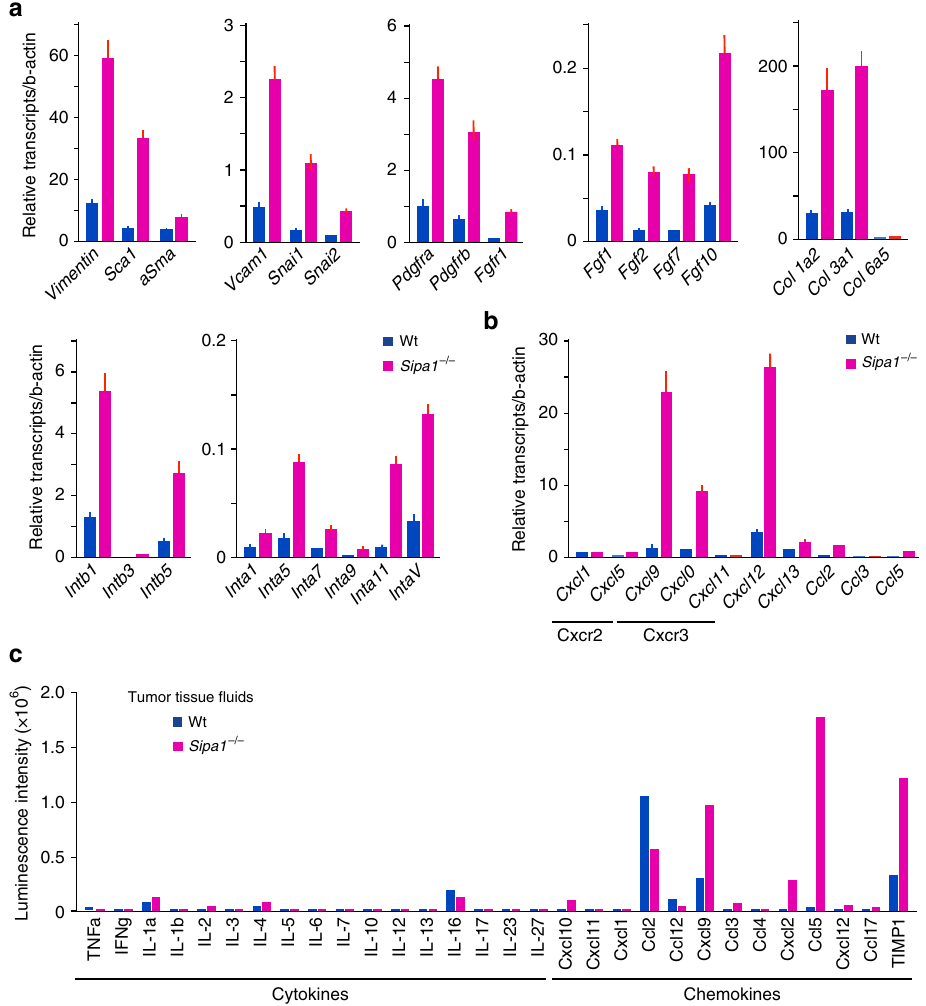
Fig. 7 Sipa1 − / − MSCs in Bcr-Abl + tumor tissue show mesenchymal gene activation with preferential production of T-cell chemokines. a , b MSCs (GFP − CD45 − Ter119 − CD31 − ) were sorted from the subcutaneous tumors of Wt and Sipa1 − / − mice on day 7 after subcutaneous injection of Bcr-Abl + HPCs, and the expression of indicated genes was assessed with quantitative PCR. Reanalysis of the sorted cell population indicated that the contamination of GFP + cells was <0.5%. Three to four mice of each group were pooled for an experiment, and independent experiments were done twice with similar results. c Cytokines and chemokines in the tissue fl uids of Bcr-Abl + tumors of Wt and Sipa1 − / − mice on day 15 after subcutaneous injection of Bcr-Abl + HPCs were assessed using mouse cytokine antibody